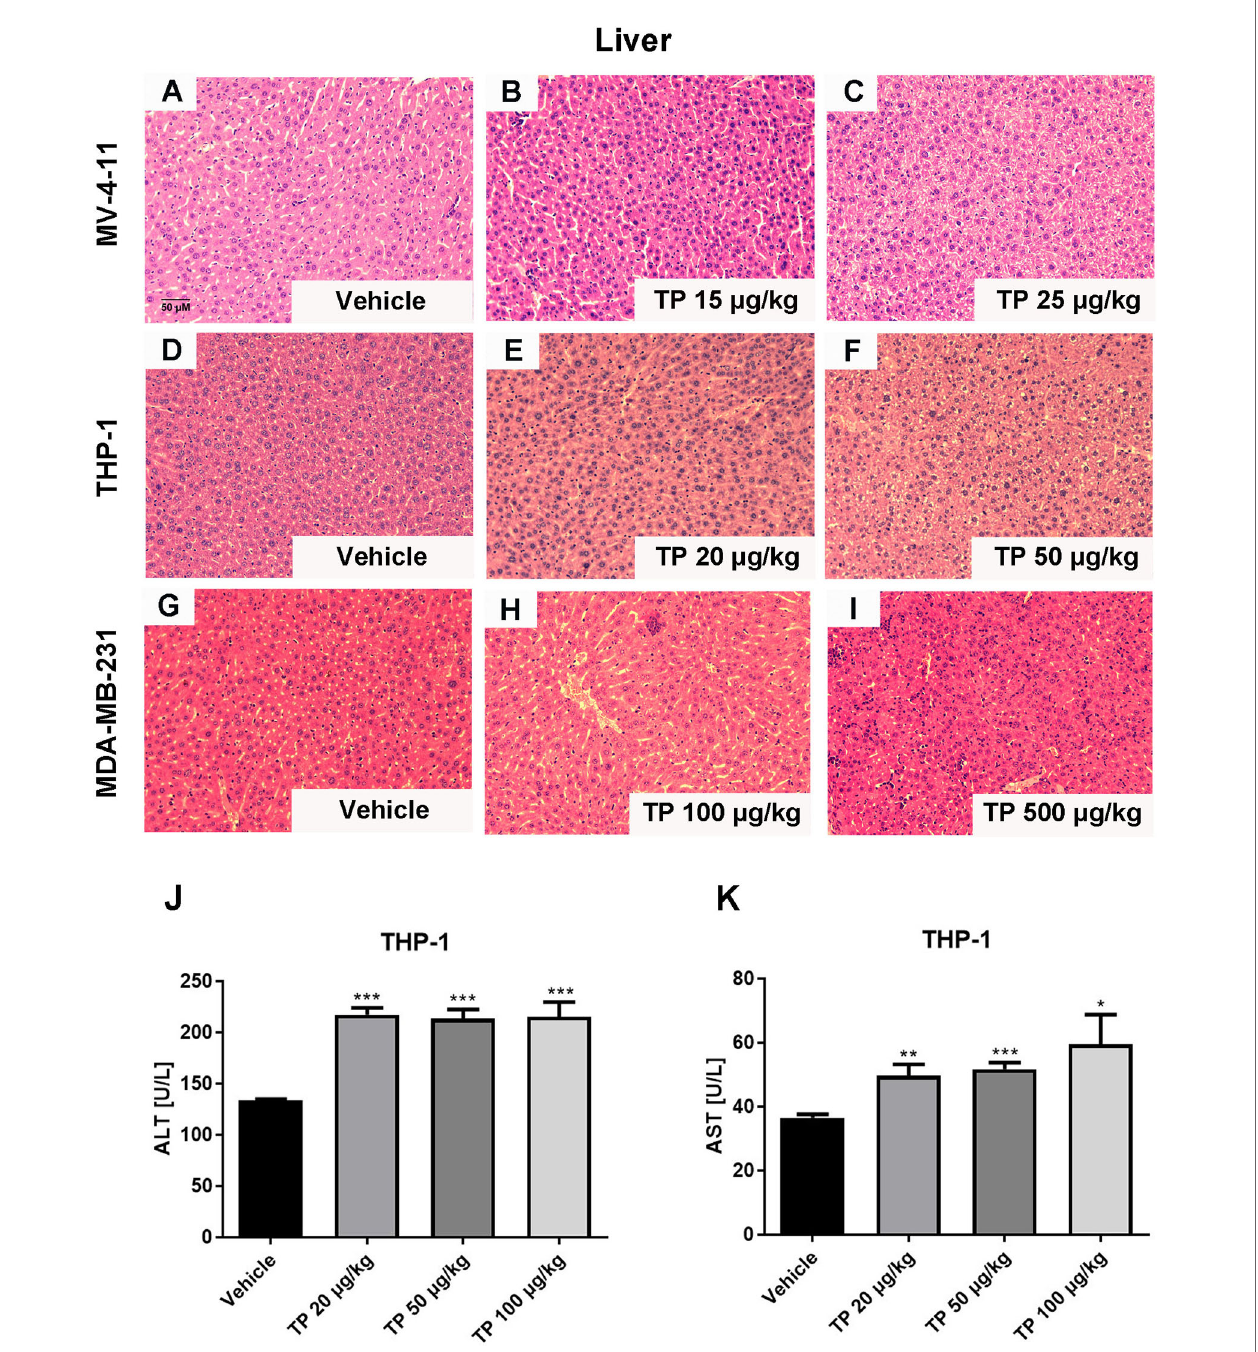
FIGURE 5 | Histopathological changes in the liver after administration with triptolide in different xenograft models. Representative microphotographs of liver sections were stained with H&E (200×) in MV-4-11 bearing mice (A – C) , THP-1 bearing mice (D – F) and MDA-MD-231 bearing mice (G – I) . (J, K) ALT and AST levels in the peripheral blood were measured after mice were sacri fi ced. * p < 0.05; ** p < 0.01; *** p <